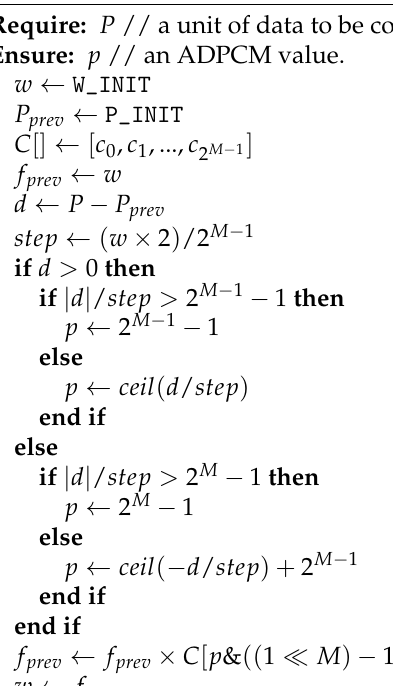
Figure 2. Encoding and decoding processes of ADPCM. Algorithm 1 Encoder of ADPCM